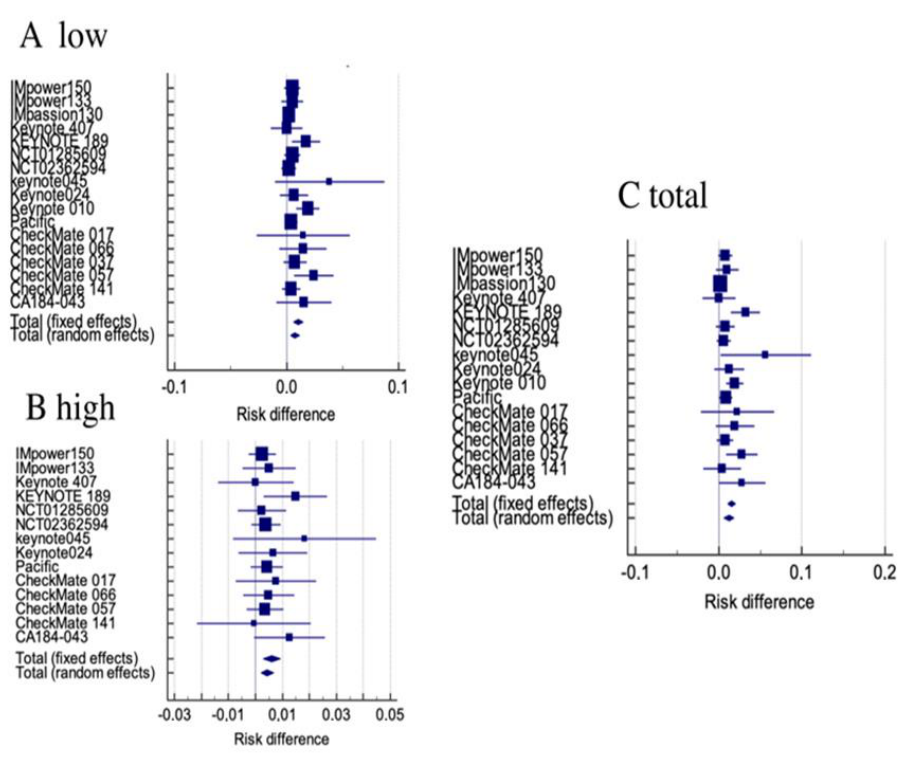
Figure 2. Forest plot of RD among patients receiving immune–checkpoint inhibitors. ( A ) Low grade toxicity, ( B ) high grade toxicity, ( C ) all grade toxicity.